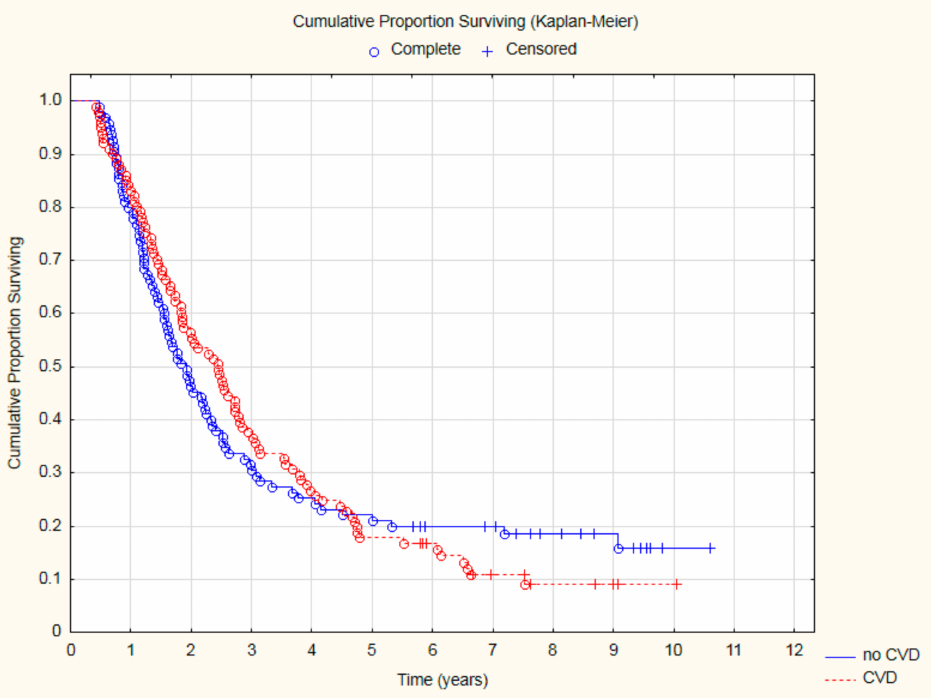
Figure 1. The comparison of overall survival in patients with and without CVD.